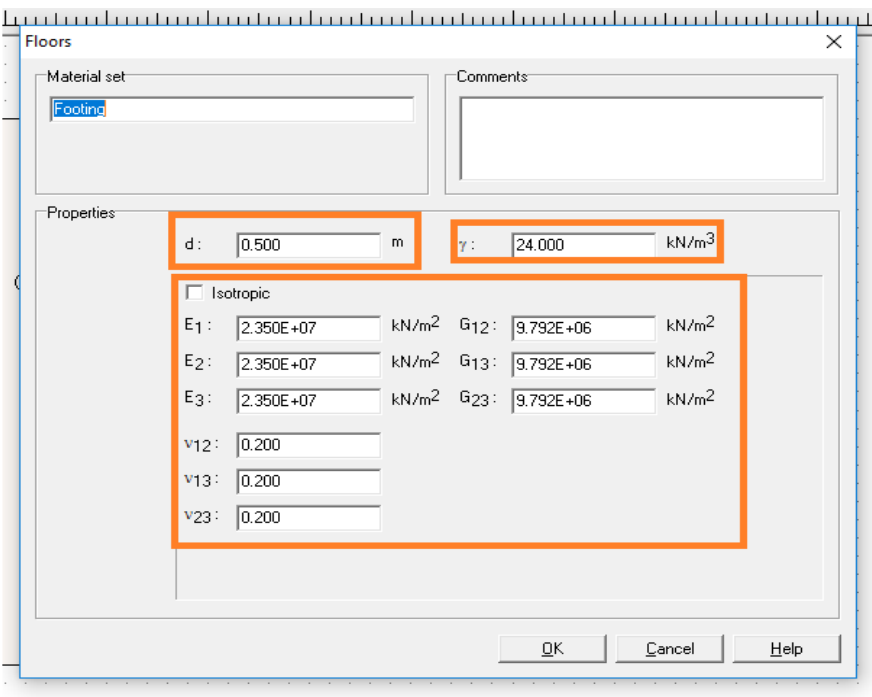
Fig. 7. Footing’s property input